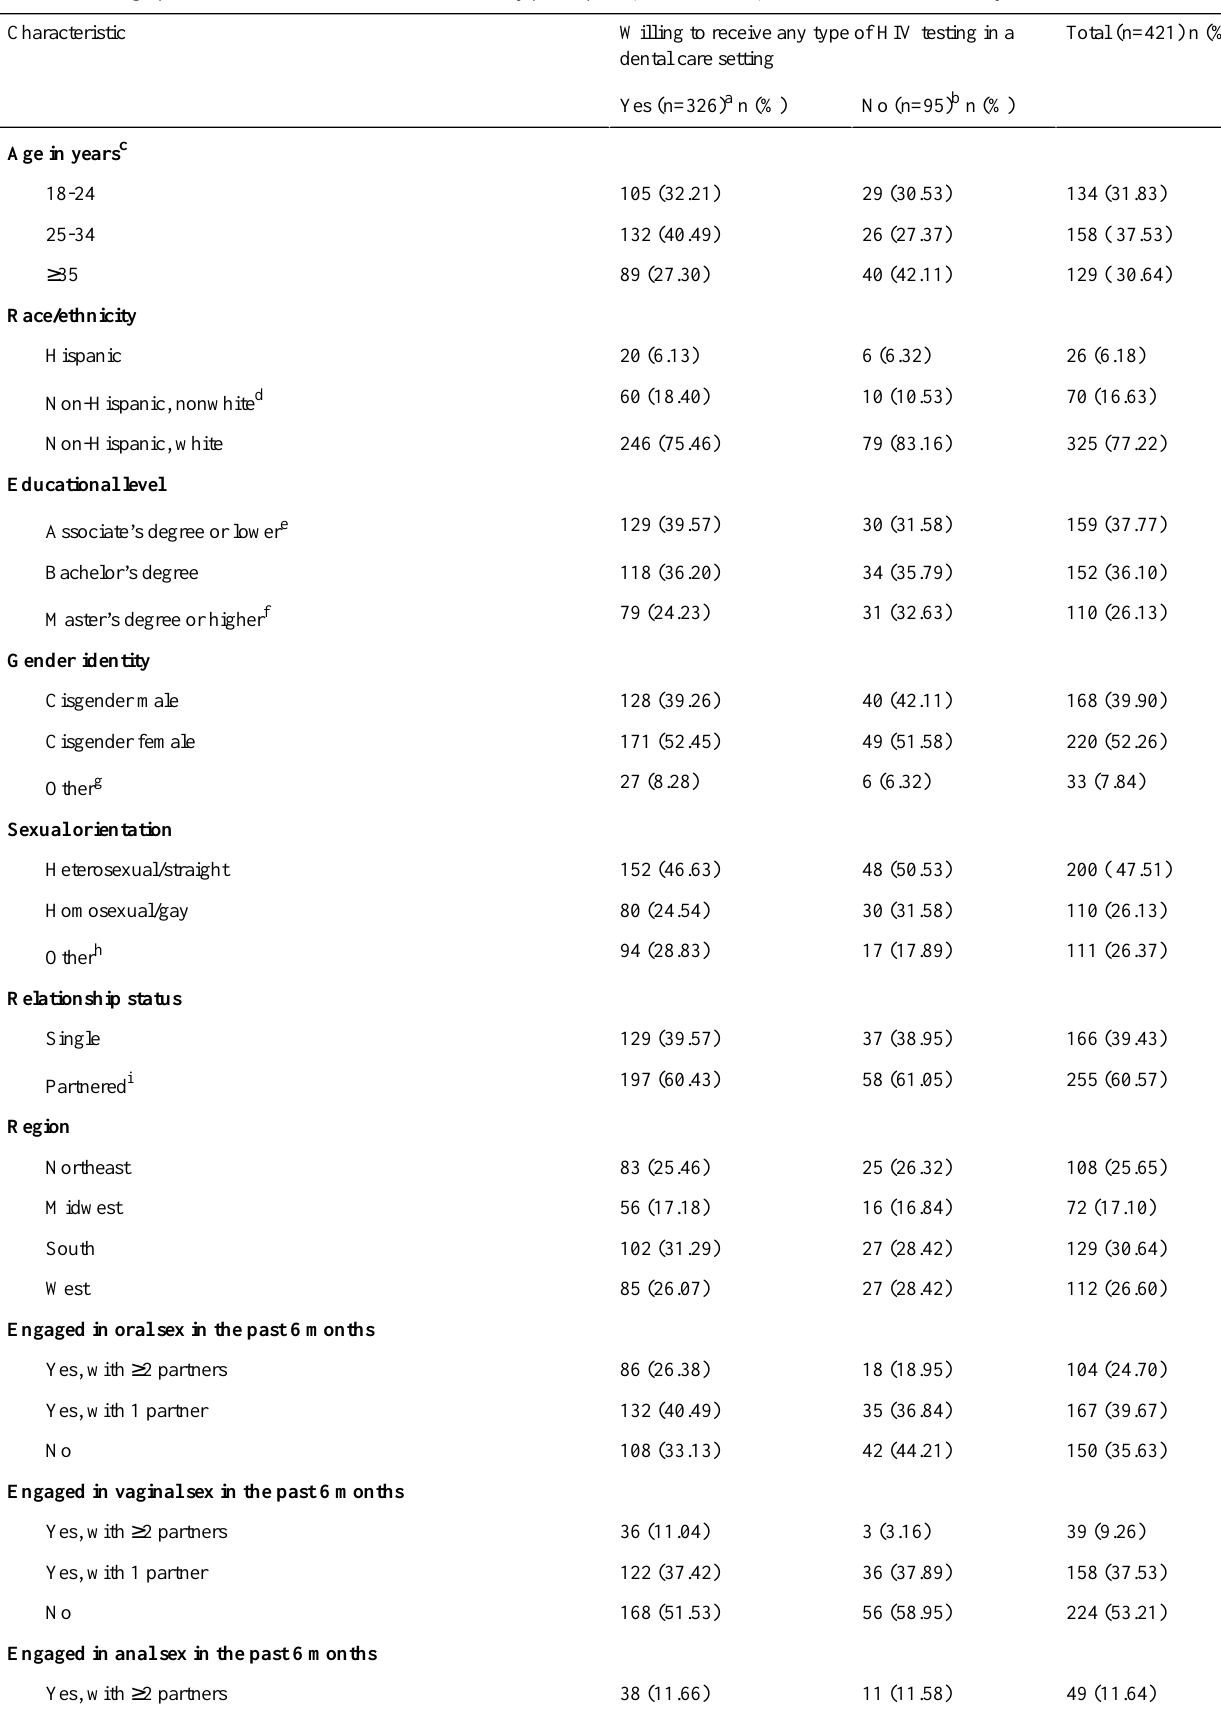
Table 1. Demographic and behavioral characteristics of study participants, United States, December 2018 to February